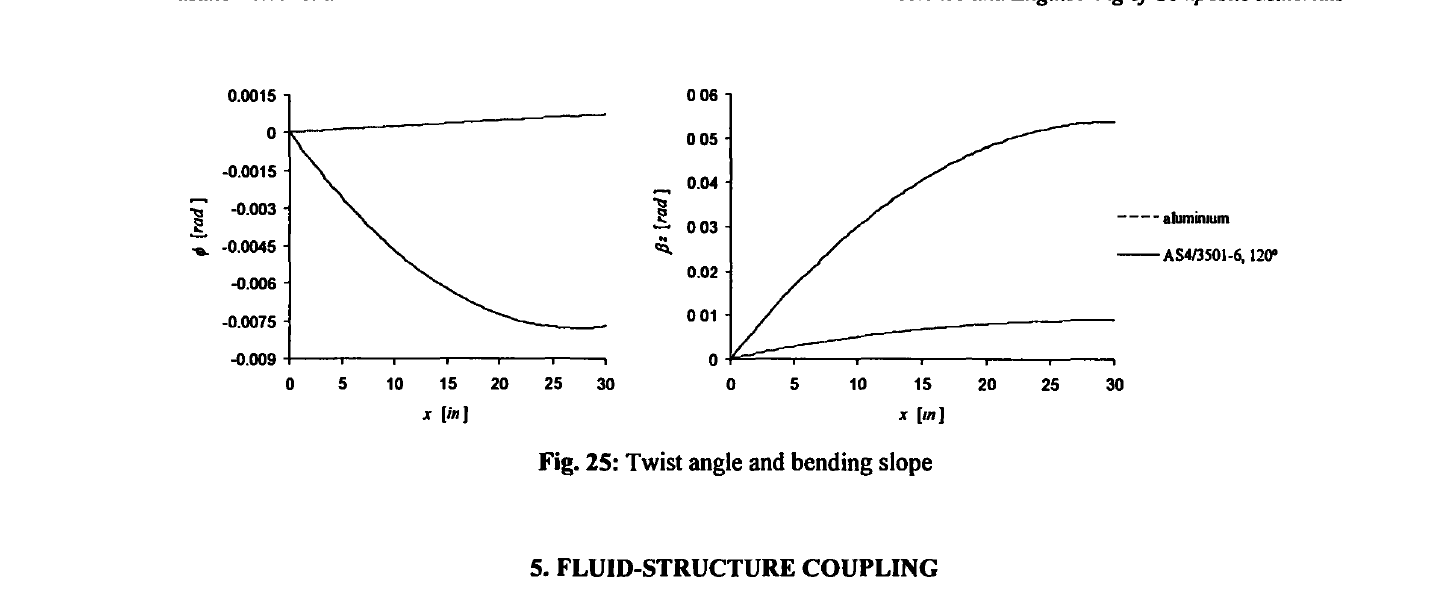
Fig. 25: Twist angle and bending